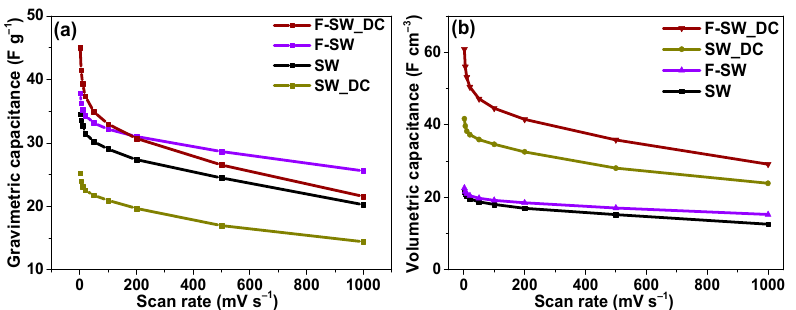
Figure 5. Gravimetric capacitance ( a ) and volumetric capacitance ( b ) of binder-free SWCNT-based films depending on scan rate. The measurements were performed in three-electrode cells.